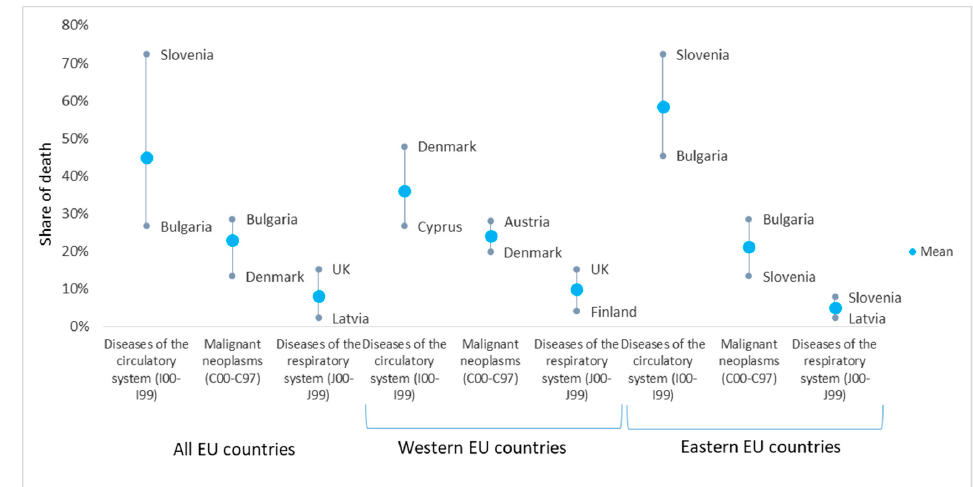
Figure 1. Causes of death in the European Union, 2011–2016. (1) Noncommunicable diseases held high shares of death in the EU between 2011–2016, mostly for diseases of the circulatory system (39%), malignancy (27%), and diseases of the respiratory system (8%). Eastern countries recorded 53% share of death (SOD) for circulatory system diseases compared to their Western counterparts (36%) but lower SOD for malignant neoplasms (24% against 29%). (2) Causes of death for all European Union countries were collected from the Eurostat and European Mortality Database, according to the codes of the International Classification of Diseases, 10th Revision (ICD-10). They cover all ages and